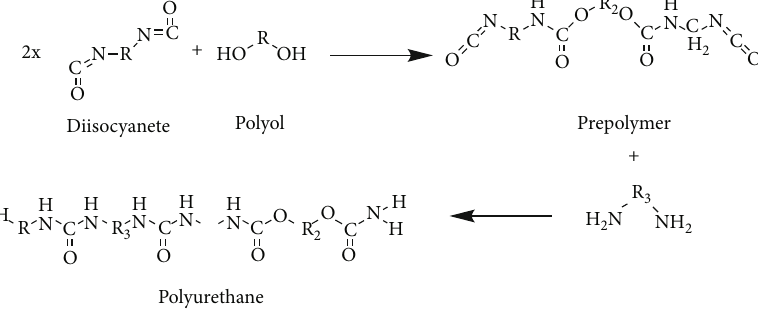
Figure 52: Synthetic pathways of polyurethane.